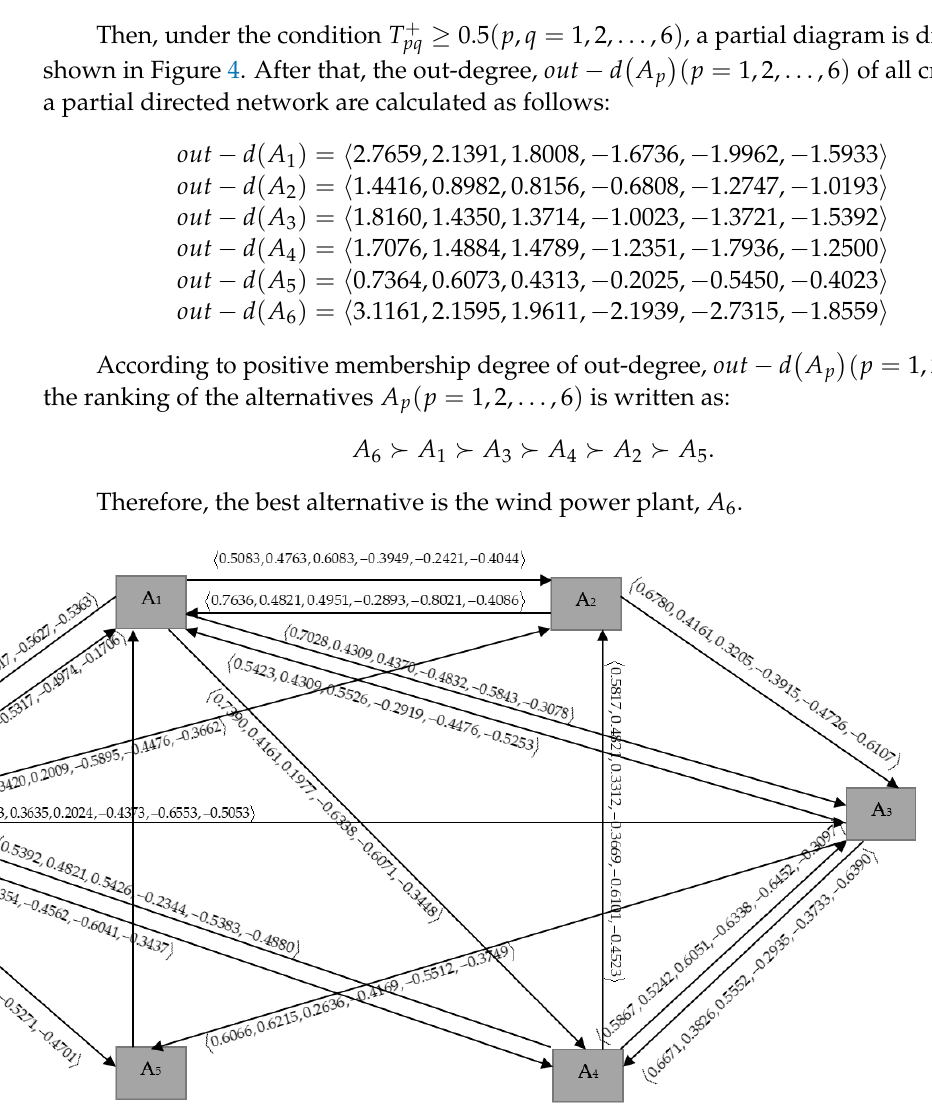
Figure 4. Partial directed network of the BSVN.